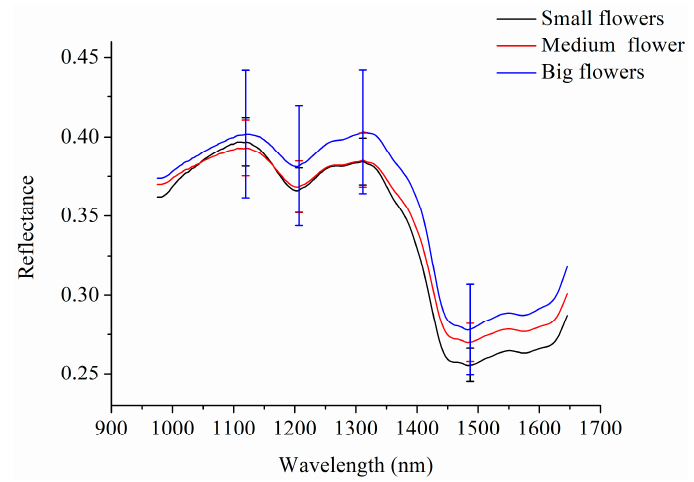
Figure 1. Average spectra with standard deviation (SD) at typical wavelengths of small flowers, medium flowers, and big flowers.